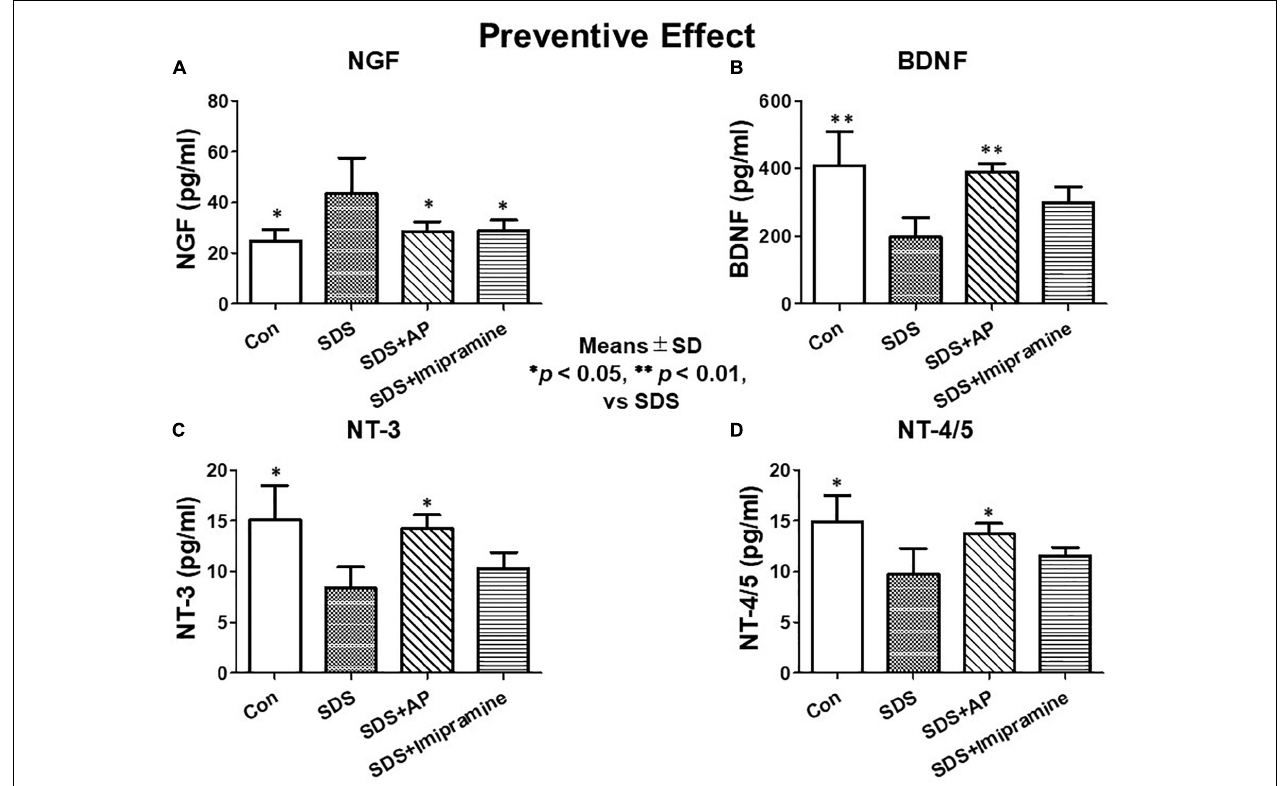
FIGURE 9 | Expressions of neurotrophic factors in the brain of SDS mice with ongoing symptoms of depression. (A) NGF, (B) BDNF, (C) NT-3, (D) NT-4/5. Results are expressed as protein content measured by ELISA. Values are means ± SD ( n = 8). ∗ p < 0.05 and ∗∗ p < 0.01 versus SDS group. AP, acupuncture; BDNF, brain-derived neurotrophic factor; NGF, nerve growth factor; NT, neurotrophin, SD, standard deviation; SDS, social defeat